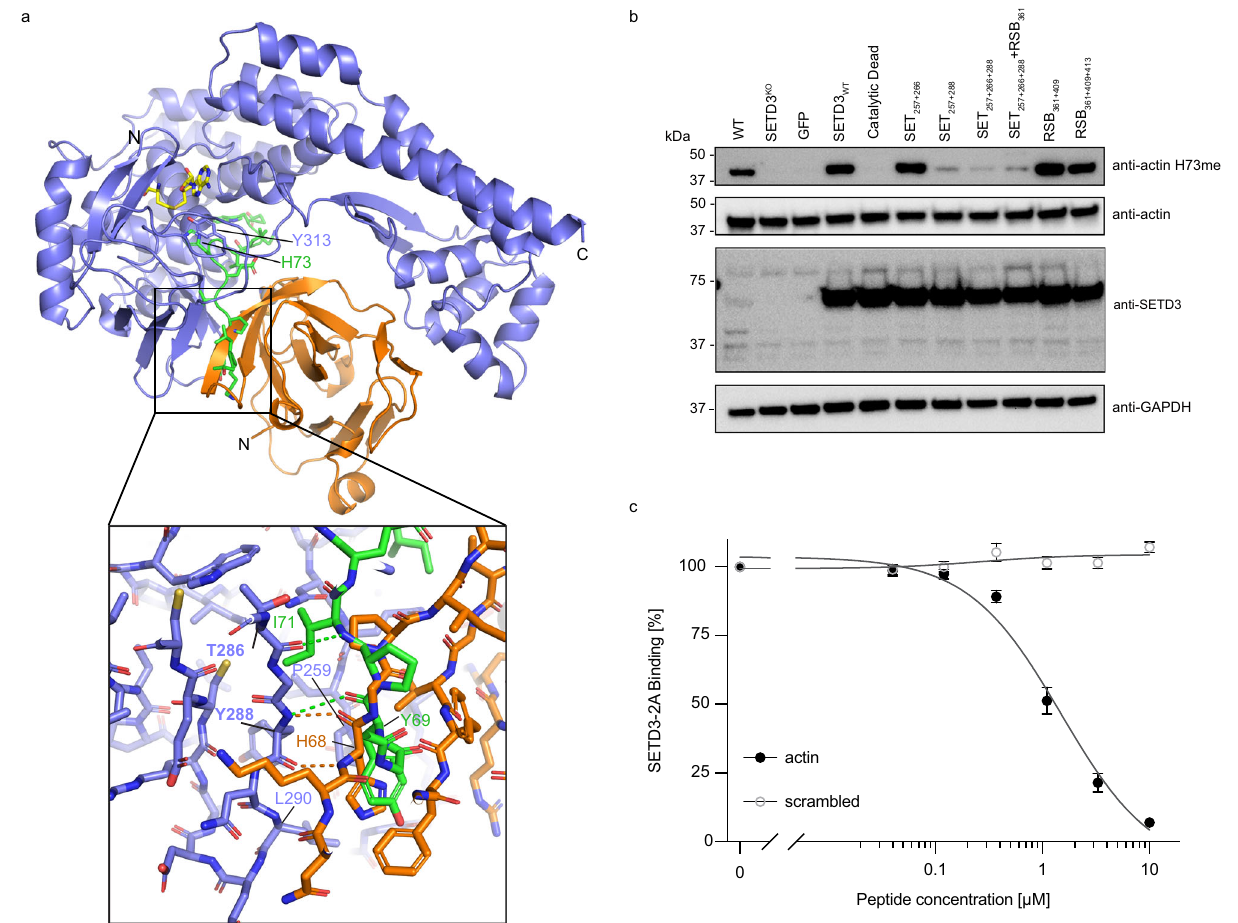
Fig. 4 | 2Abinding partiallyoverlapswith the substrate binding site atthe SET interface. a Superposition of SETD3-2A cryo-EM structure and SETD3-actin com- plex (PDB ID 6mbk) with SETD3 from actin complex not shown. SETD3-2A ribbon modelcoloursasinFig.2, β -actinboundtoSETD3iscolouredingreen.S-adenosyl-l- homocysteine (SAH) in yellow, actin substrate residue H73, and SETD3 Y313 are shown as stick models located in the active site of SETD3. Inset shows details of the intermolecular β -sheet structure observed between CV-B3 2A protease and SETD3 and between β -actin and SETD3, with important contact residues and hydrogen